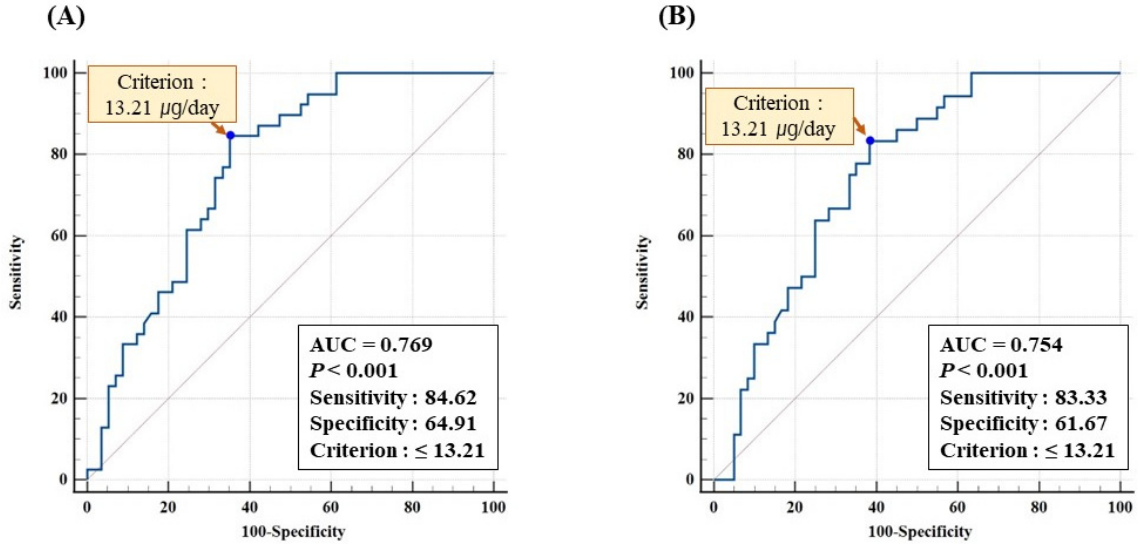
Figure 5. Receiver operating characteristic (ROC) analysis for optimal vitamin D intake at